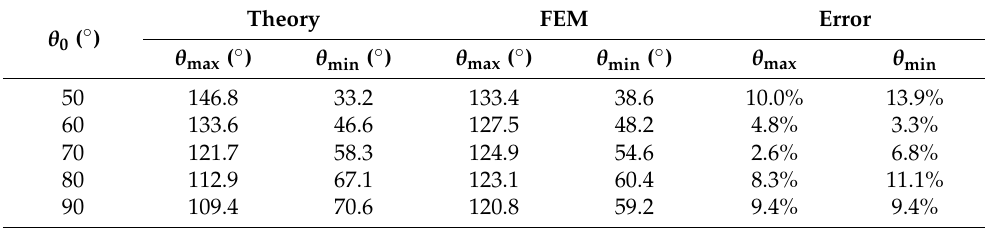
Table 7. Comparison of the theoretical and numerical results for different θ 0 .